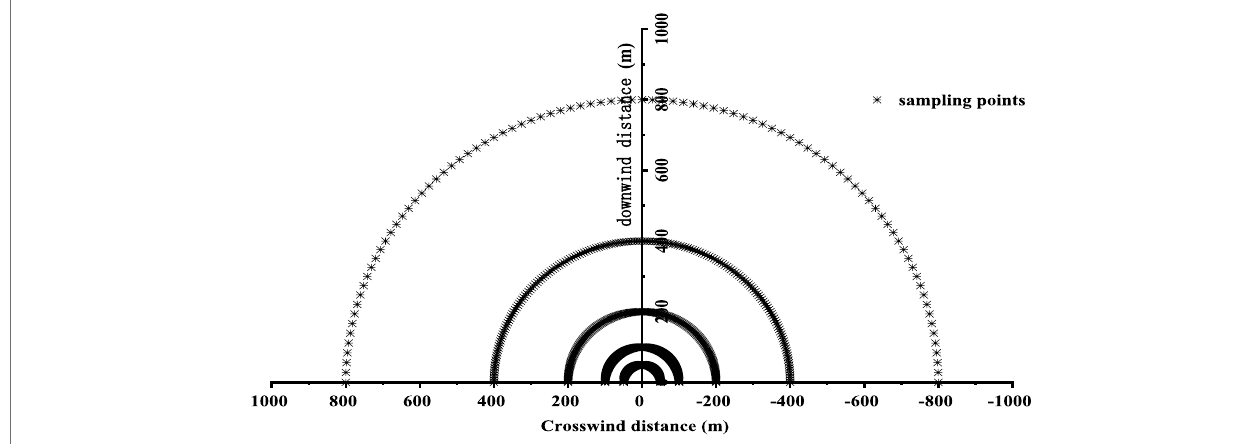
FIGURE 1 | Sketch of the fi eld experiment monitoring points ’ setting pattern.